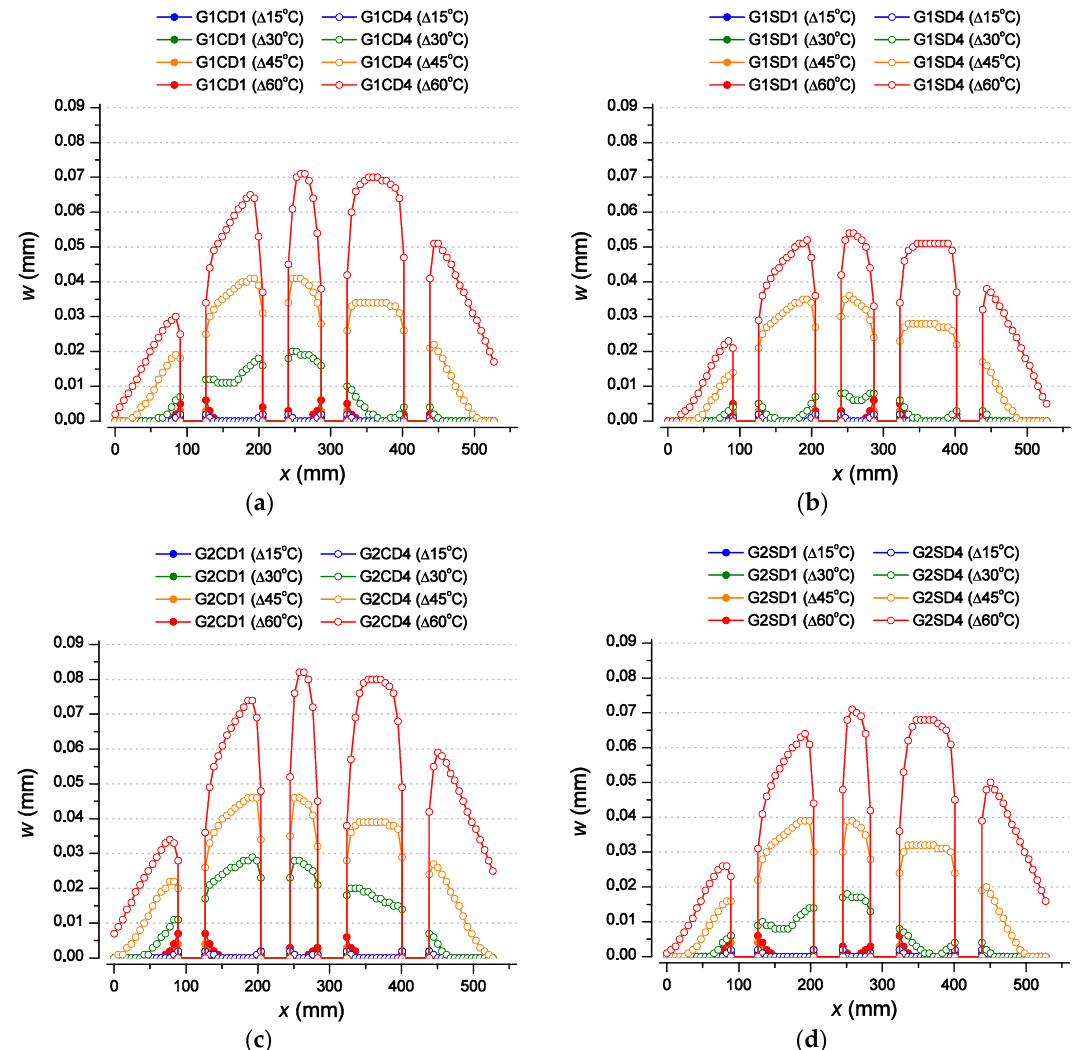
Figure 11. Maximum crack opening profile along the sleeper axis for D1 and D4 sleepers for different temperature increments, using carbonate aggregates for G1 ( a ) and G2 ( c ) and siliceous aggregates for G1 ( b ) and G2 ( d ).